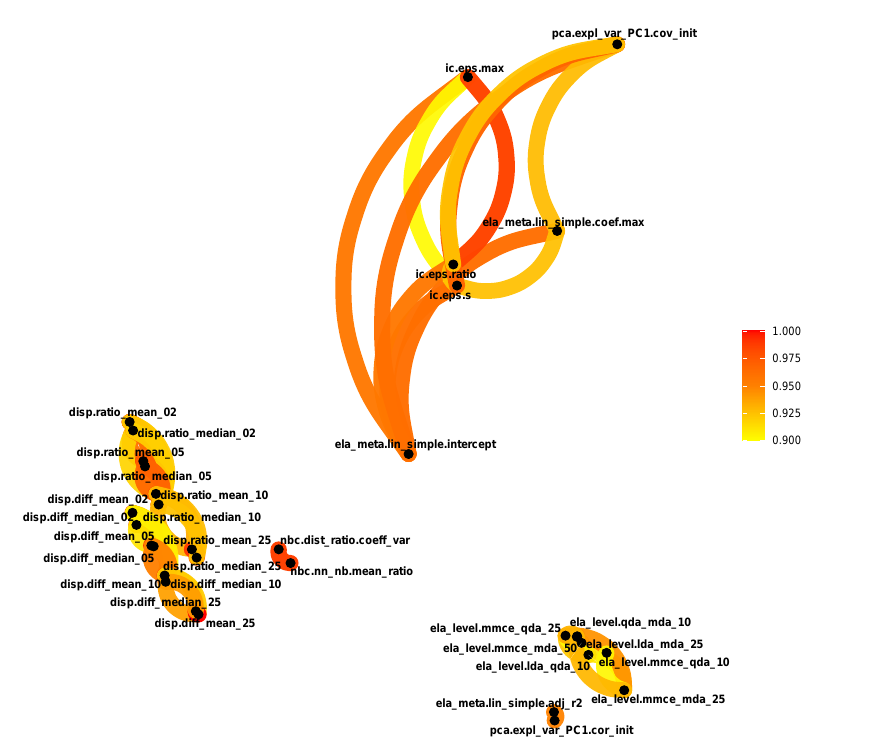
Figure 4. Plot of the graph based on the MIC scores. Nodes represent ELA measures. Edges represent a strong association between two ELA